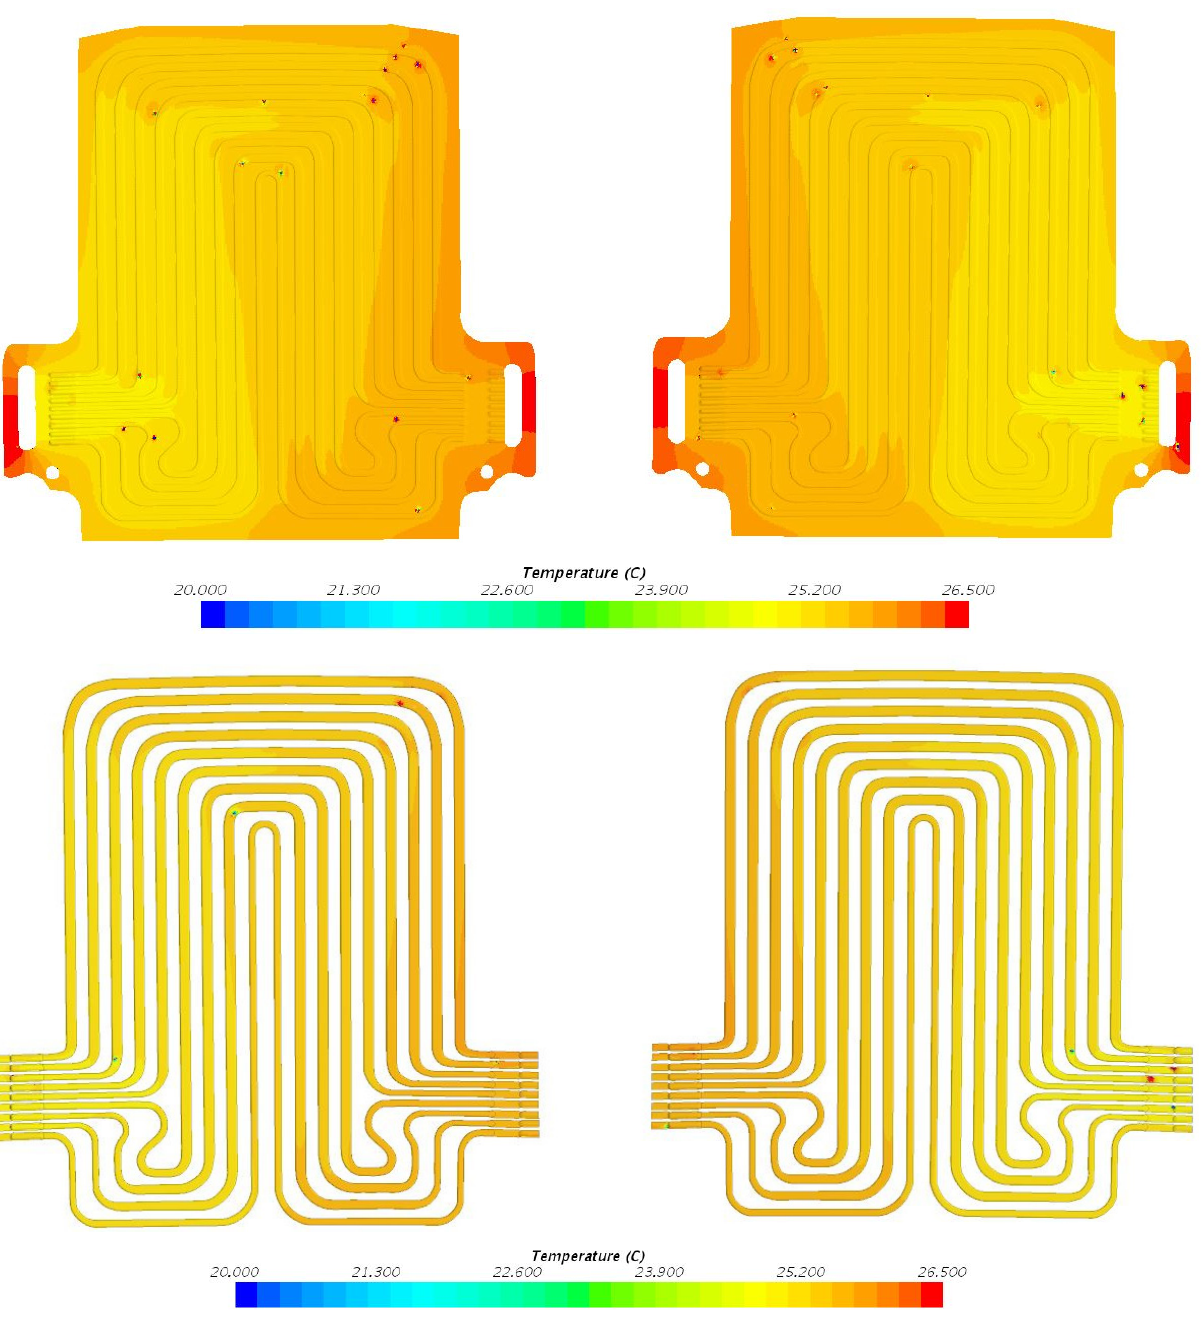
Figure 9. Temperature field at 20 A discharge current and 25 °C coolant inlet temperature with heat flux at position 1 = 148.2 W/m 2 , position 2 = 168.9 W/m 2 , and position 3 = 74.4 W/m 2 .